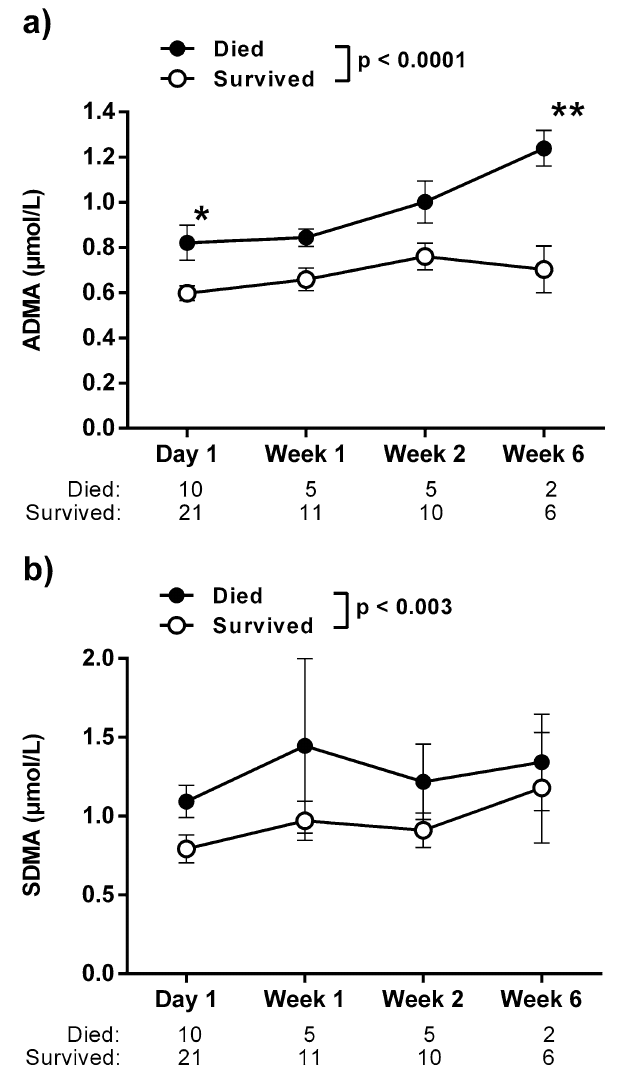
Figure 2. Time course of ADMA ( a ) and SDMA ( b ) serum concentrations of hospitalized COVID-19 patients during in-hospital treatment. N refers to the number of patients for whom blood samples were available for analysis at each time point. P values given in the legend refer to two-sided ANOVA for trend between groups; asterisk mark statistically significant differences between both group at a specific time point in Bonferroni’s multiple comparisons test. * p < 0.05, ** p < 0.01 between